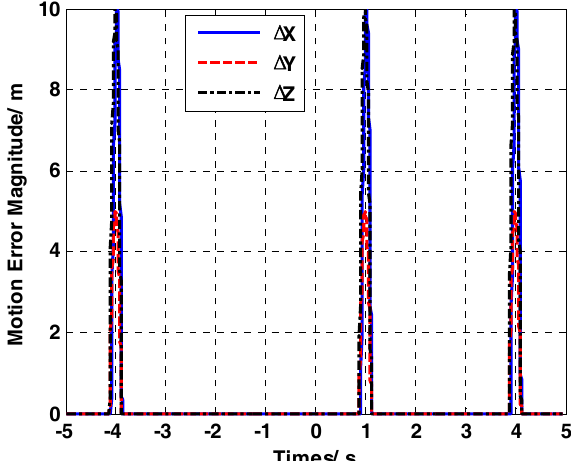
Figure 12. Burst ‐ like perturbation error of the axes.